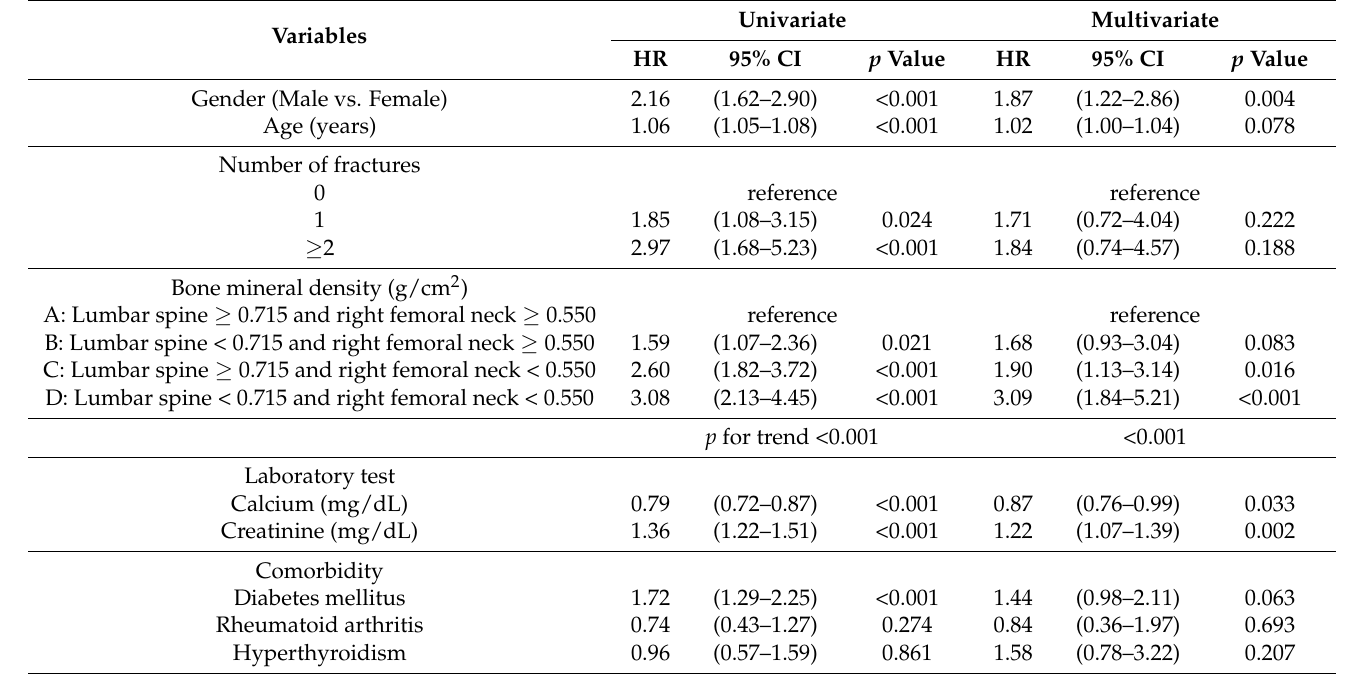
Table 3. Cox regression analysis for mortality risks in participants who had discontinued anti- osteoporosis medication.